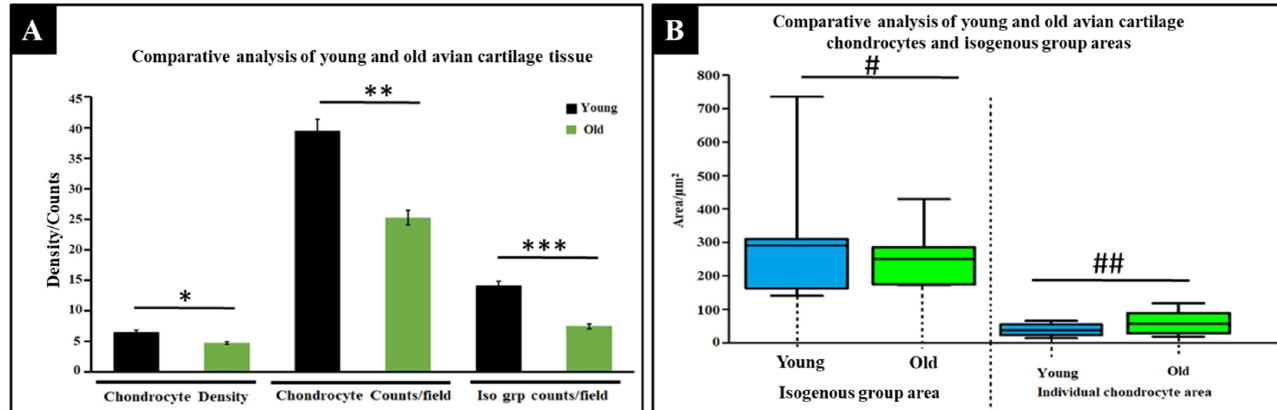
Figure 4. Comparative analysis of chondrocyte densities isogenous group areas and individual chondrocyte areas in young and old decellularized avian articular cartilages. ( A ) Cell densities of cartilages between young and old avian articular cartilages, chondrocyte’s count in the cartilage tissue of young and old avian articular cartilages, the number of isogenous groups found in young and old avian articular cartilages. ( B ) Assessments of densities of isogenous group areas and individual chondrocytes’ area of avian cartilage tissue. ( A ) n = 8, ( B ) n = 30. * p = n = 8, * p- value = 2.04824 × 10 − 4 , ** p- value = 0.04152, *** p- value = 0.03128, # p- value = 0.93348, ## p- value = 0.50867. Legend: Iso group = Isogenous group.